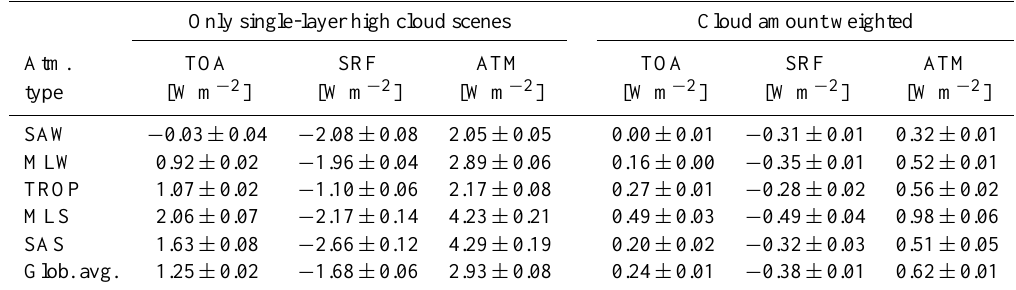
Table 6. Differences in radiative fluxes for July: real IWC( z ) profiles vs. constant IWC( z ), supplemented with interannual variability for 2007–2009 (values in brackets). Global average is area weighted. Only single-layer high cloud scenes Cloud amount weighted Atm. TOA SRF ATM